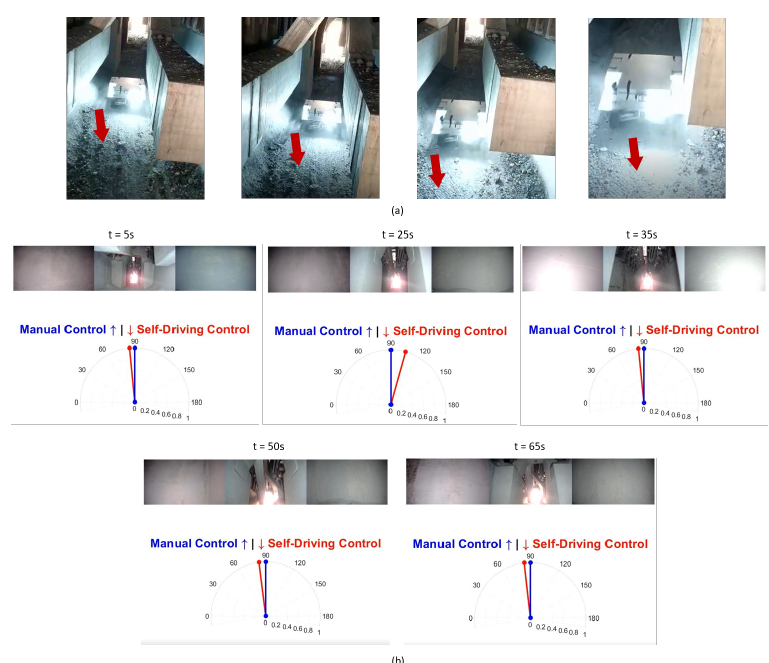
Figure 15. [Site test run 1] Self-Driving on-site results: Figures in ( a ) show the robot going into the environment autonomously. Figures in ( b ) represent the robot’s view and the true vs. regressed steering angles.